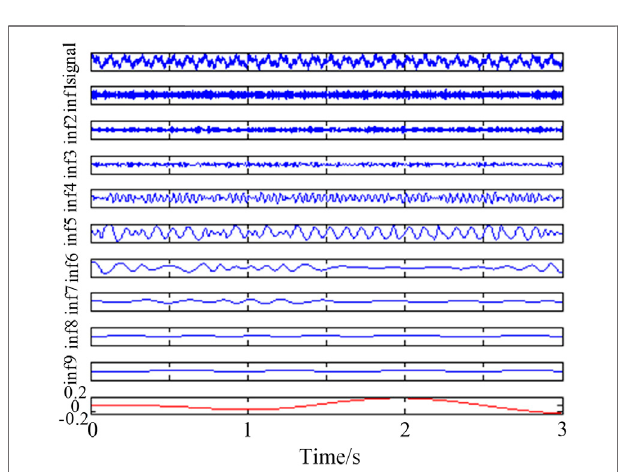
FIGURE 10 | Energy proportion of different IMF